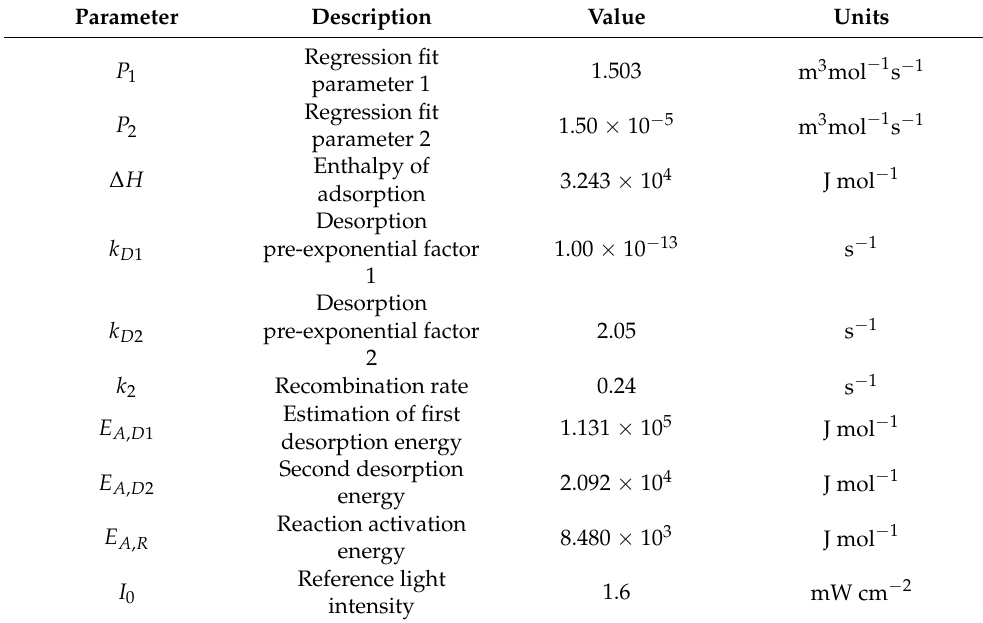
Table 1. Values of the kinetic parameters.